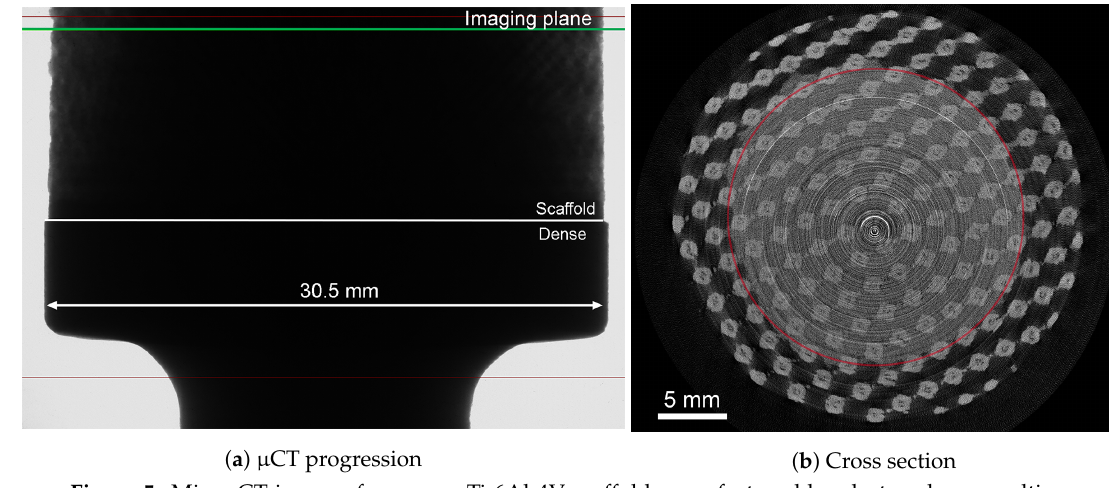
Figure 5. Micro CT image of a porous Ti-6Al-4V scaffold manufactured by electron beam melting. ( a ) Shows the µ CT progression. The green line indicates the cross-section imaging plane for ( b ). The red circle represents the area where the metallic powder is trapped